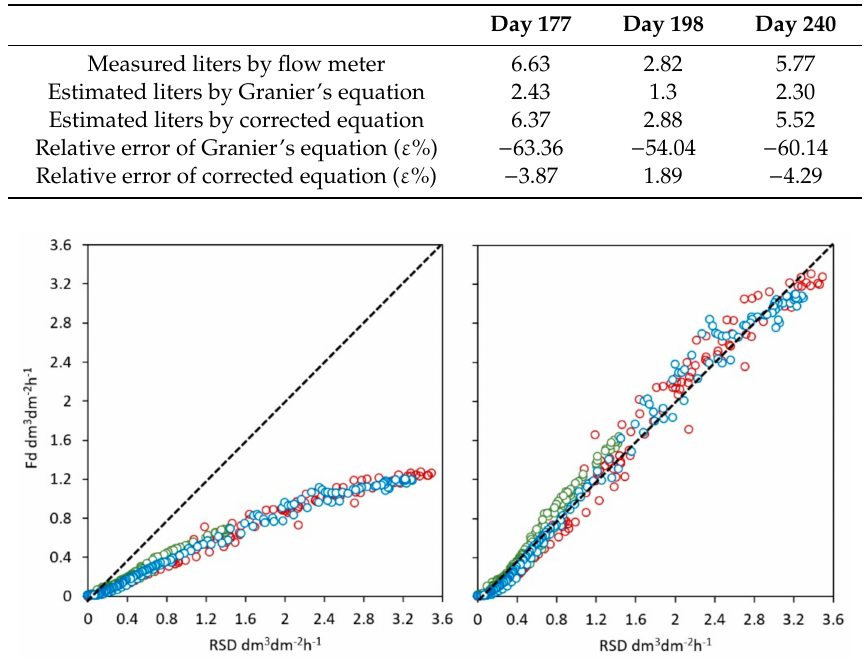
Figure 5. Relationship between the reference sap-flow density (RSD, from liquid flow meter) and the sap flow calculated with the Granier’s equation ( Fd , left ) and the new corrected equation ( Fd c , right ). Di ff erent colors show di ff erent stems at day 177 (red), 198 (green), 240